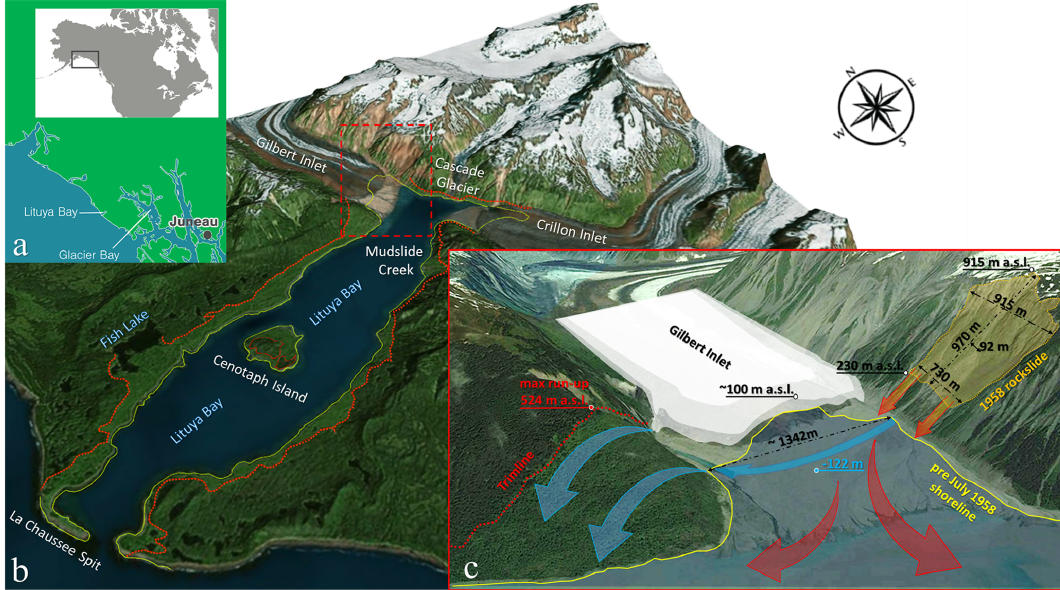
Figure 1. (a) Location of Lituya Bay, in southeastern Alaska (modified from Bridge, 2018). (b) View of Lituya Bay: the yellow line represents the shoreline before July 1958, and the red line shows the trimline of the tsunami. (c) Gilbert Inlet, showing the situation in July 1958 pre- and post-tsunami: the rockslide dimension (orange), the maximum bay floor depth of − 122m (light blue), and the maximum run-up of 524ma.s.l. (Miller, 1960) on the opposite slope with respect to the impact area are indicated (topography data from © Google Earth Pro 7.3.2.5776; last access: 24 April 2020).